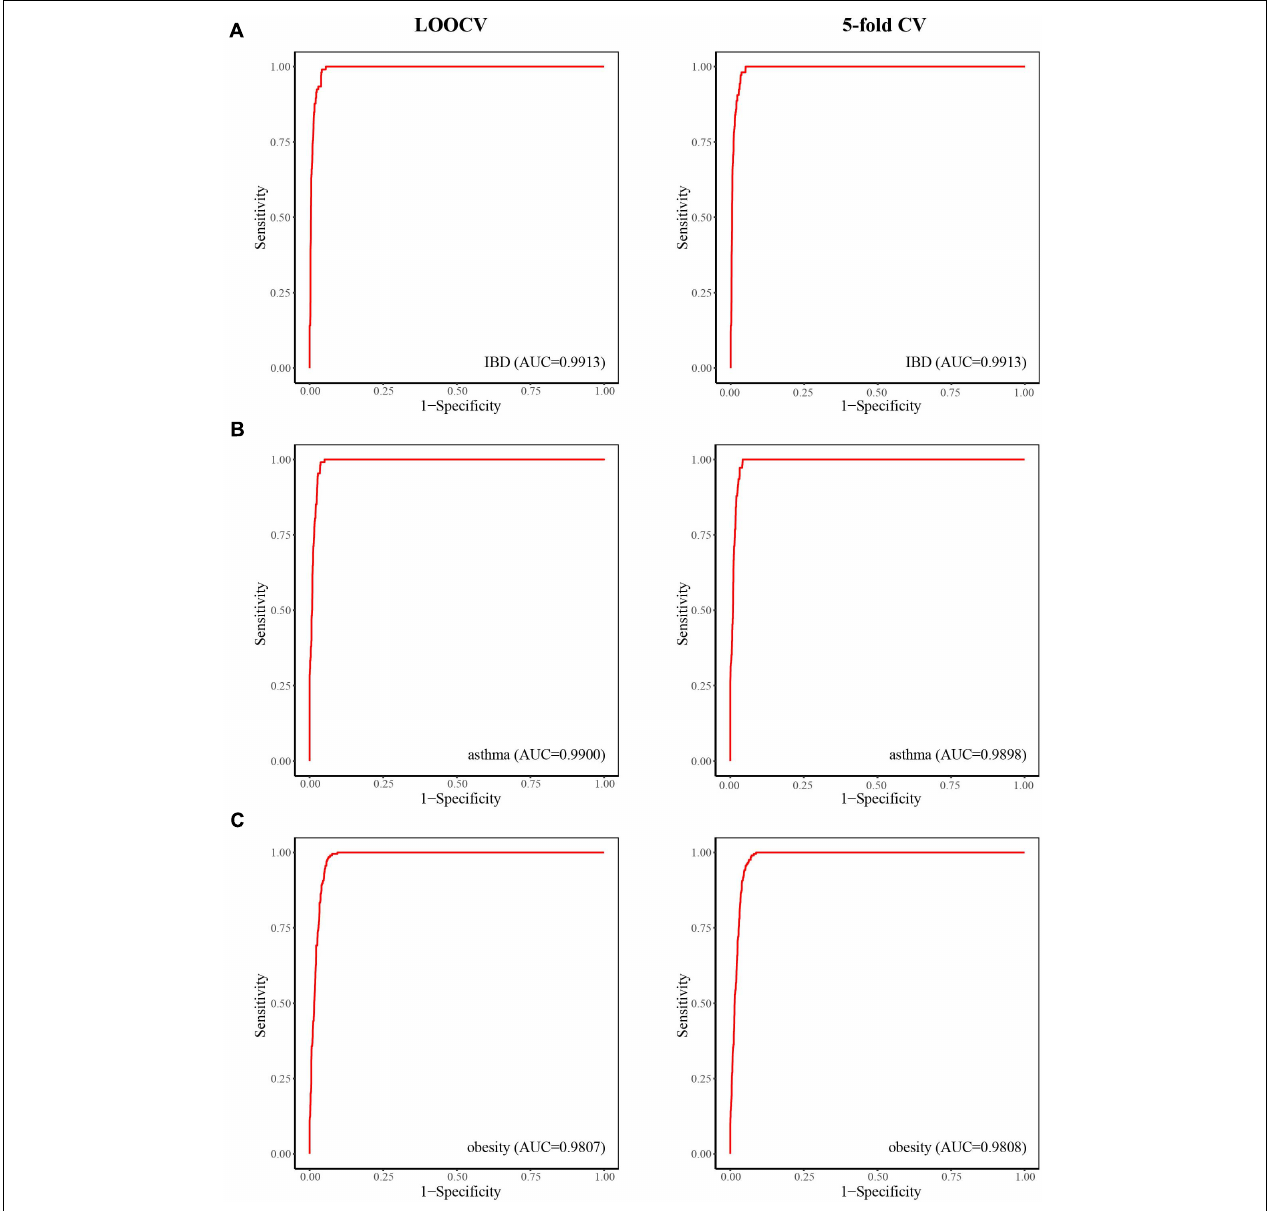
FIGURE 3 | The predictive power of LOOCV (left) and fivefold CV (right) for IBD (A) , asthma (B) , and obesity (C) .